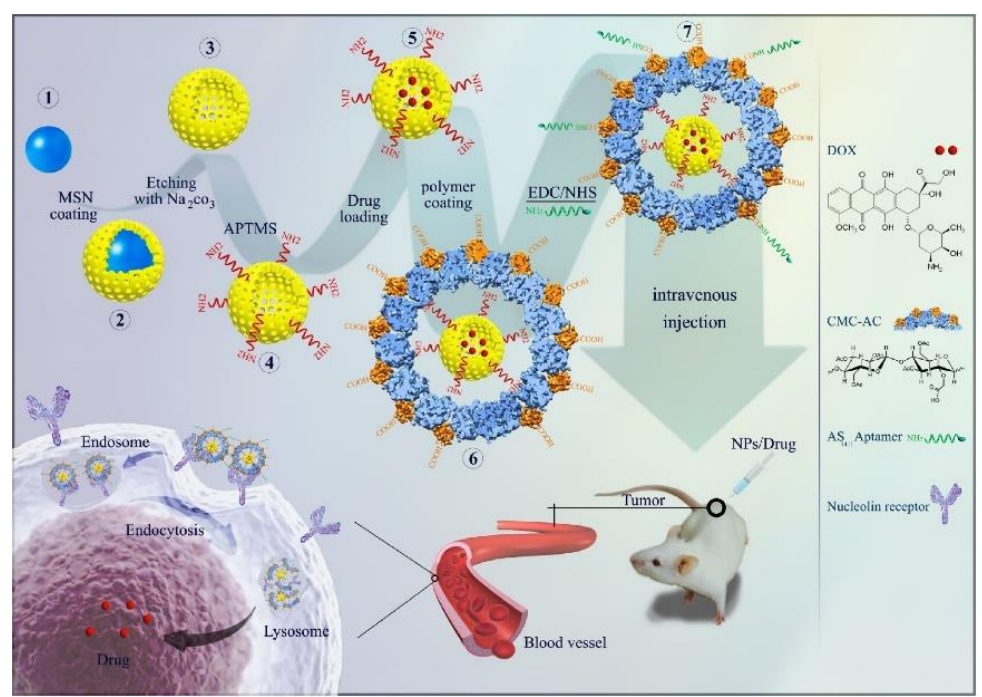
Figure 5. Schematic representation of the functionalizing process ( top ) and targeting and drug release mechanism ( bottom ) of hollow MSNs coated with acetylated carboxymethylcellulose (Ac-CMC) decorated with aptamer. Reproduced with permission from ref. [151]. Copyright 2018 Elsevier Ldt.